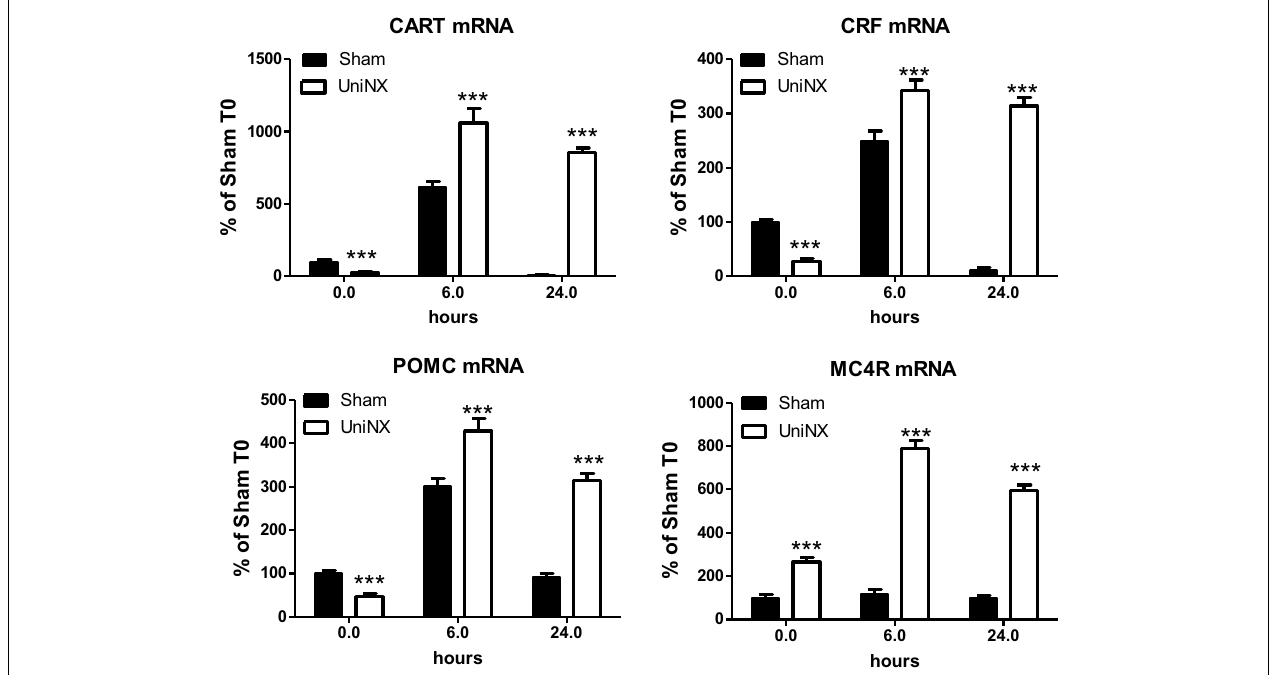
FIGURE 6 | Hypothalamic mRNA levels of anorexigenic neuropeptides CART, CRF, MC4R, and POMC in Sham and UniNX animals after 6 and 24h after i.p. LPS injection . Values are means (cid:6) SE; n = 8/group. *** p < 0.001 corresponds to Sham vs.